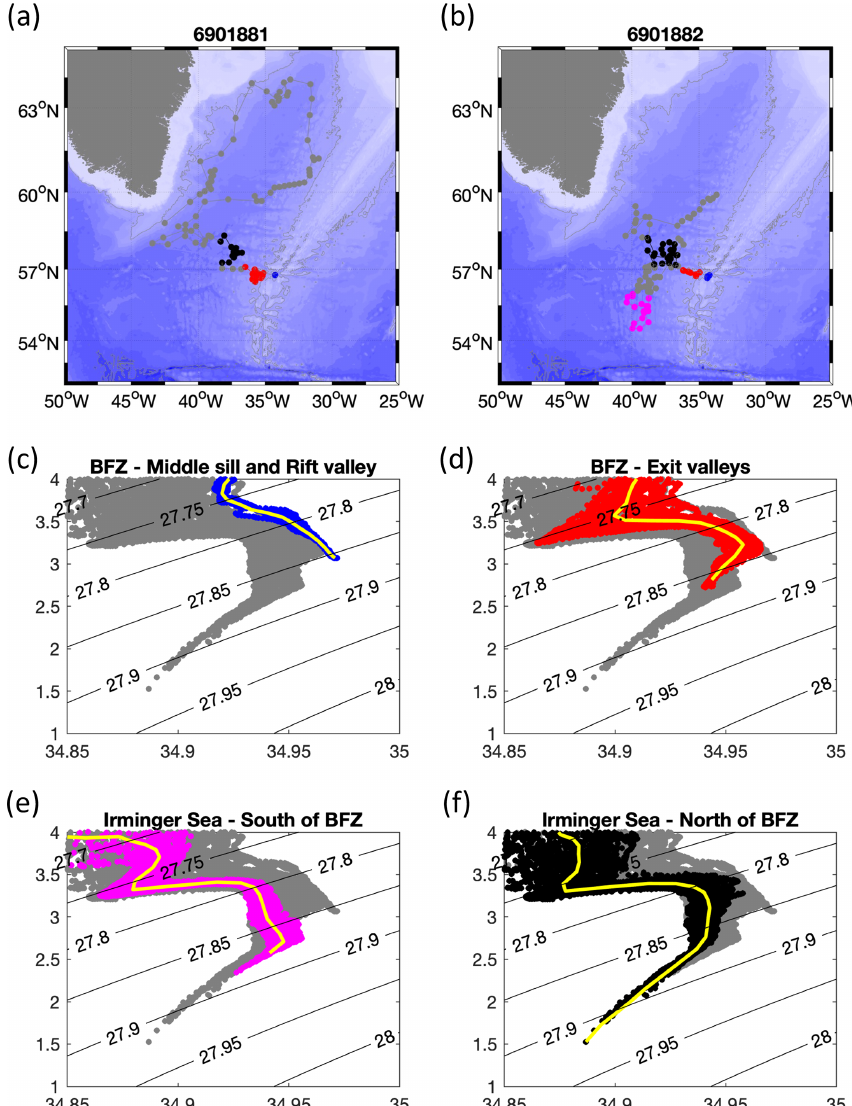
Figure 6. (a–b) Trajectories of Deep-Arvor floats 6902881 and 6902882 from the Middle section with dots locating profiles distant of 10d. (c–f) Associated θ – S profiles for the ISOW density range. Colors in θ – S plots refer to the location of the profiles in panels (a) – (b) , from the interior of the BFZ (blue dots) to the interior of the Irminger Sea north of the BFZ (black dots). In yellow are the averaged properties of the colored